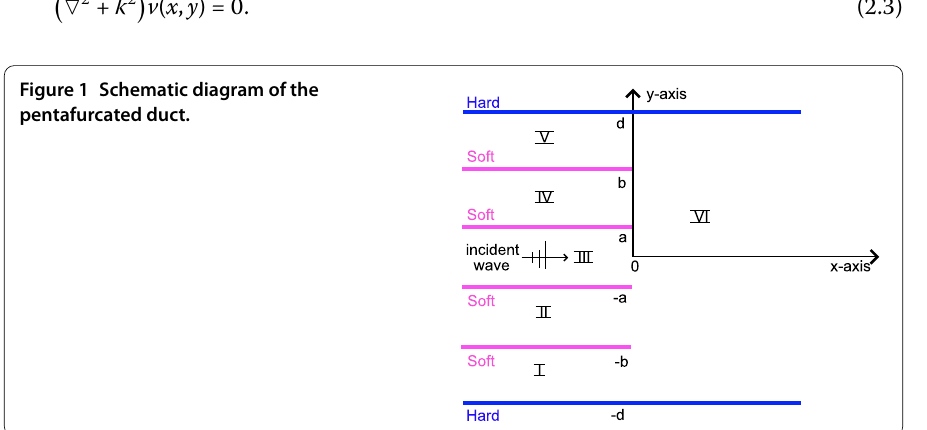
Figure 1 Schematic diagram of the pentafurcated